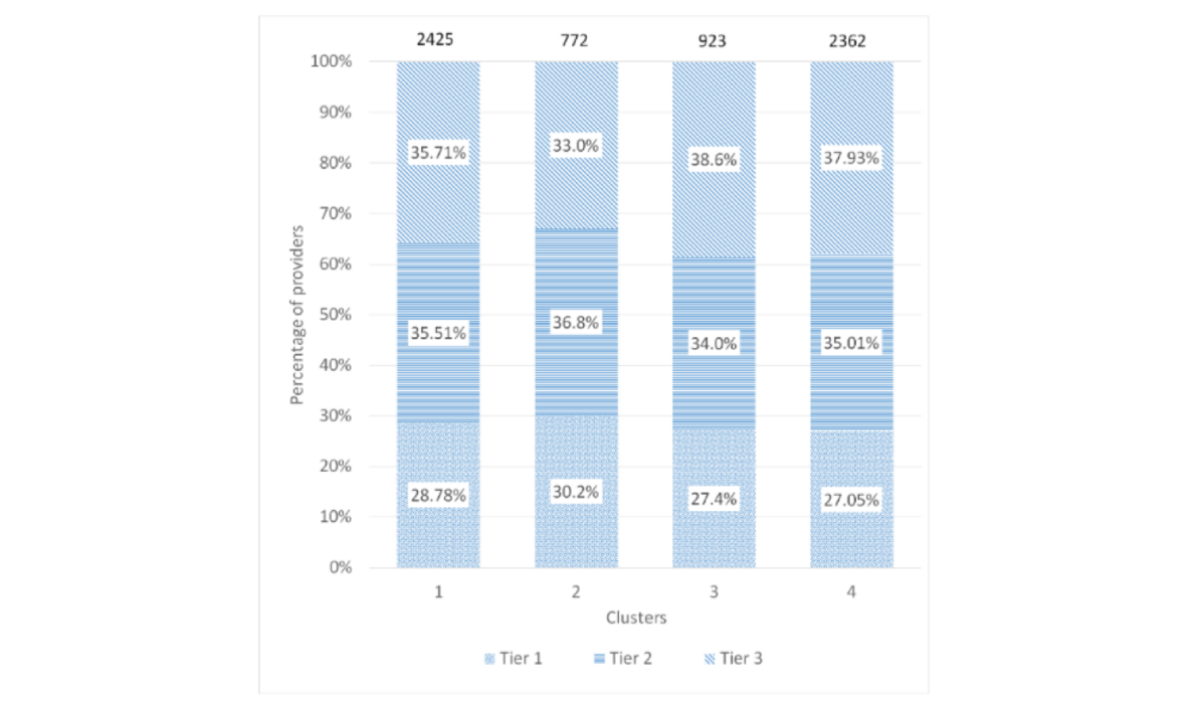
Figure 5. Composition of clusters by city